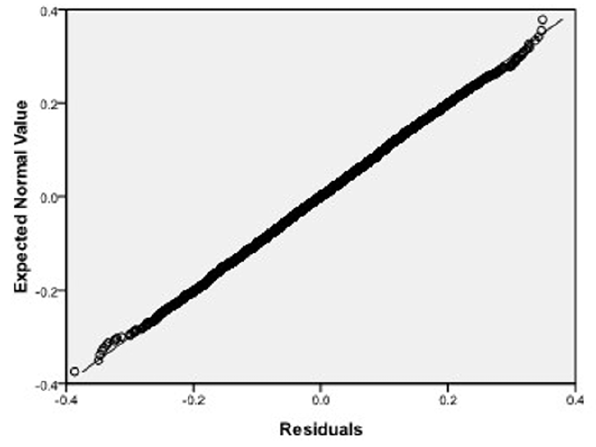
Figure 28. Normal Q-Q plot of residuals of ^ bb 0 of OLS when the variance function of the error term is s 2 ( x 1 , x 2 ) ~ exp ( { ( x 2